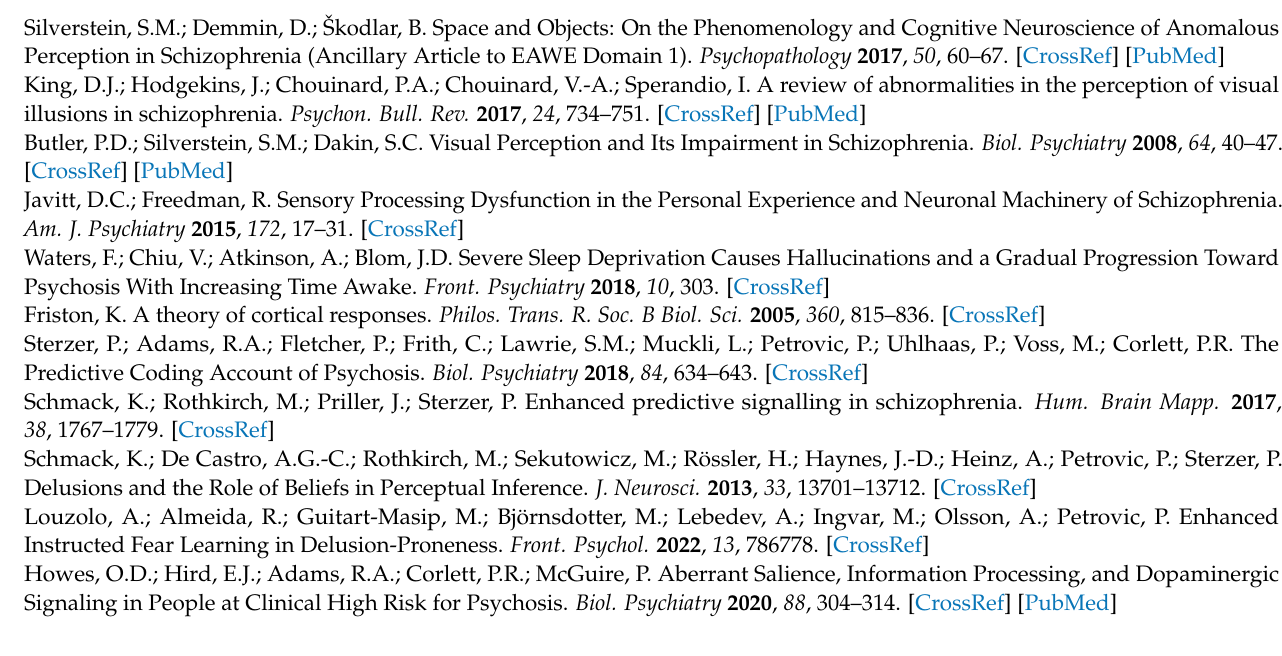
model; Table S2. Model coefficients for the secondary model; Figure S1. Interaction effect of sleep condition by PDI-21 mean distress score. Error bars and bands represent 95% confidence intervals; Figure S2. Correlations between all outcomes of the PDI-21 questionnaire. Kernel density plots of the distributions of each outcome are presented along the